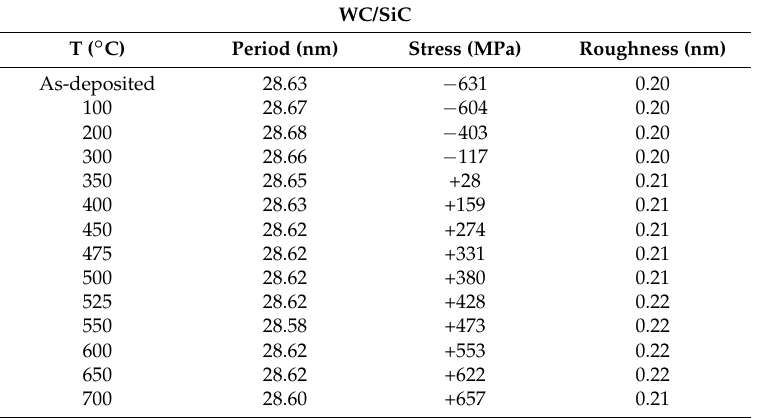
Table 2. WC/SiC multilayer period, stress and surface roughness as a function of annealing temperature. These data were collected on the same 100 bilayer multilayer (28.63 nm), which was measured after each annealing step. Roughness is AFM measured surface